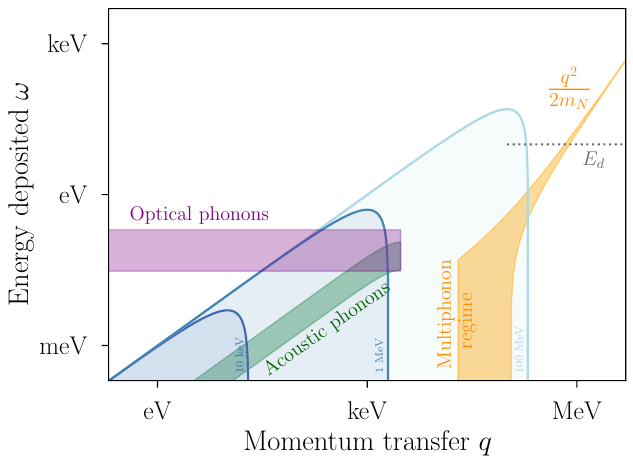
Figure 8: For DM-nucleus interactions, the response at high q is highly peaked about ) . As the energy drops below the displace- the free-nucleus dispersion ω = q 2 / ( 2 m N ment energy for a nucleus in a potential, E , the response about the free-nucleus d dispersion broadens and we enter the multiphonon regime at q ∼ 10 − 100 keV. For q well below ∼ 10 keV, the dynamic structure is dominated by resonant response on the acoustic and optical phonon dispersions, corresponding to single phonon excita- tions. Kinematically allowed regions for DM scattering are shown for m χ = 10 keV, 1 MeV, and 100 MeV at v = 10 − 3